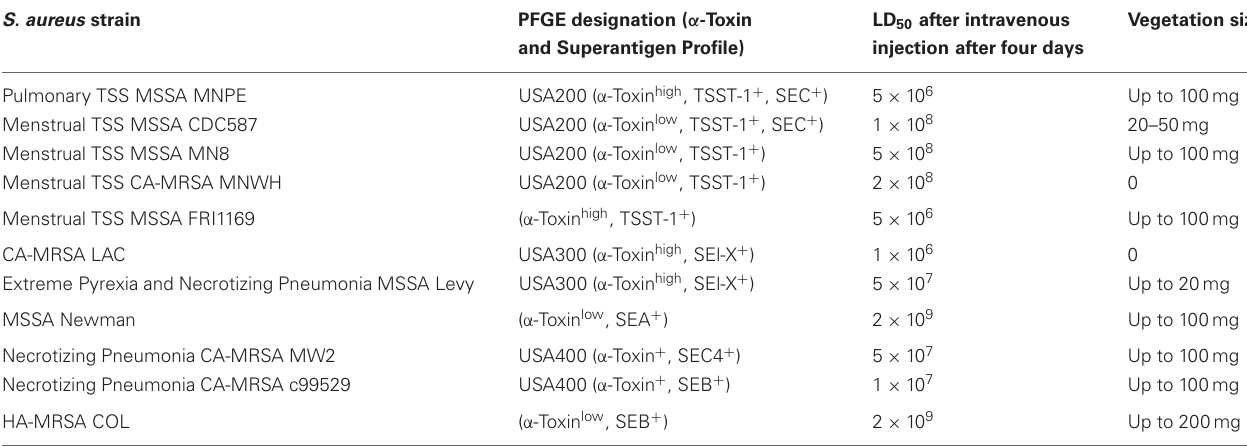
Table 1 | Lethality and infective endocarditis production by Staphylococcus